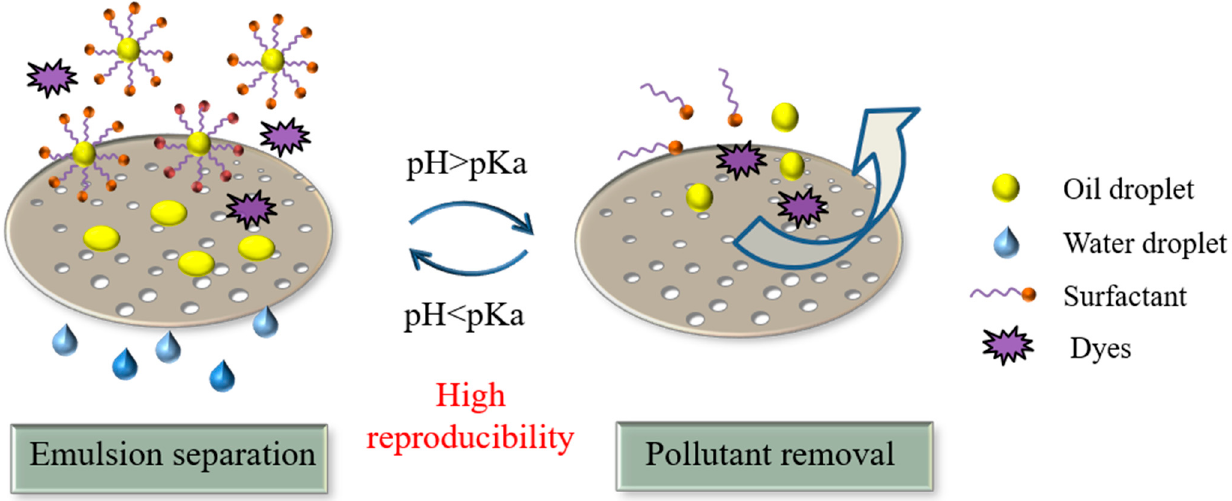
Figure 1. Scheme of pH-sensitive membrane for the application of emulsion separation and the removal of dyes and surfactants.